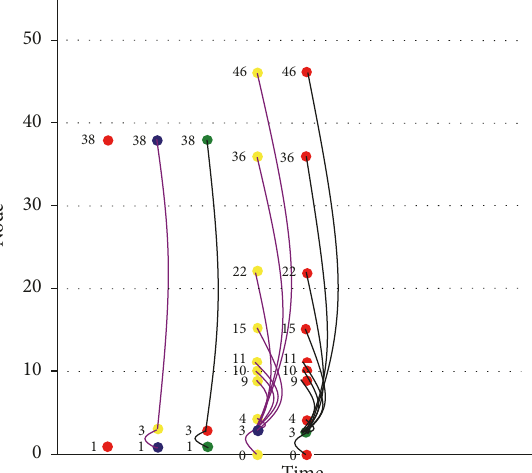
Figure 7: Temporal complex network. The dynamics of nodes and connections are depicted. See the text for the definition of the colors and axes.